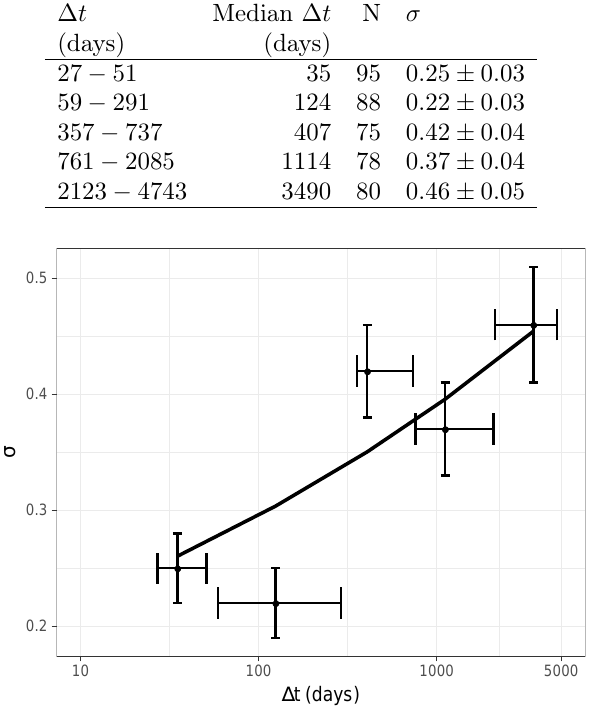
TABLE 4 AGN variability for subsets of observations separated by different intervals in the observer’s frame. The first column gives the range in intervals between observations and the second gives the median value. The third column gives the number of AGN in the resulting subsample and the final column gives the constraints on σ . For all fits, β was fixed at a value of 1.24.